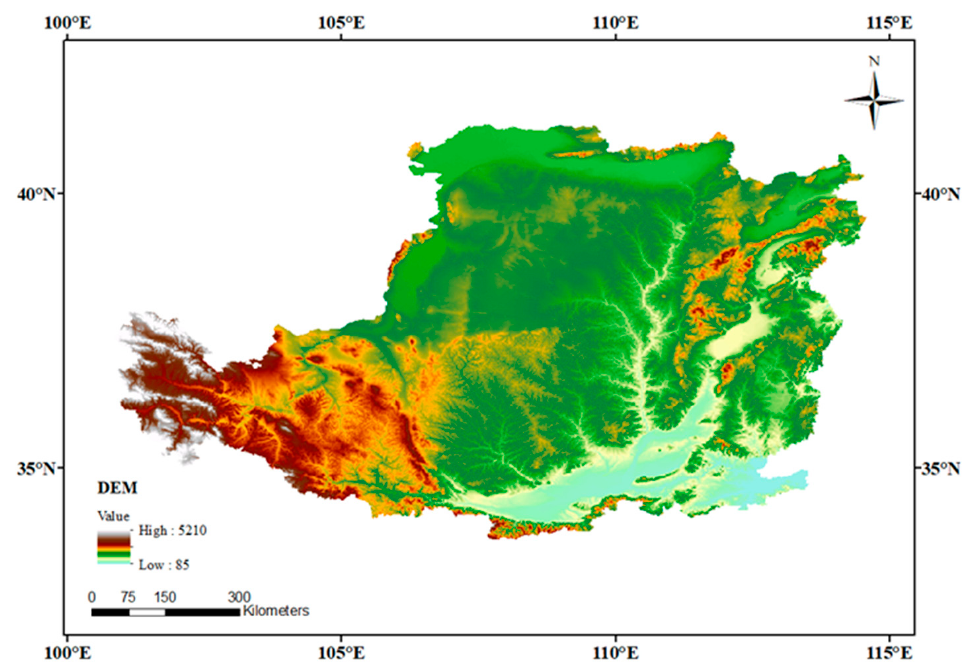
Figure 1. The elevation of the Loess Plateau.